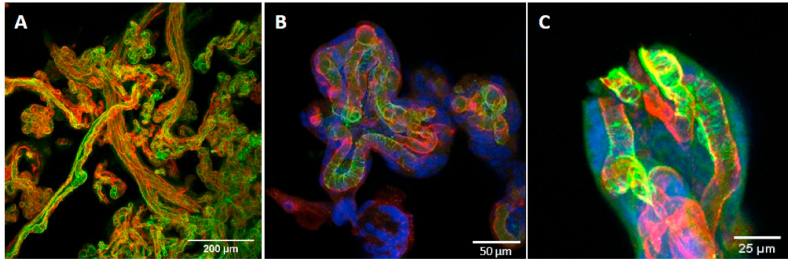
Confocal images of placental pericyte fingers stained with smooth muscle α-actin and PDGFRβ (note n = 1). (A) Low resolution image showing staining with smooth muscle α-actin (green) is widespread across the villi (endothelium = red). (B) High resolution image showing pericyte fingers expressing smooth muscle α-actin (green) around vessels (AAL = red, DAPI = blue). (C) High resolution image of pericyte bodies and fingers expressing PDGFRβ (green), AAL (red) and DAPI (blue).